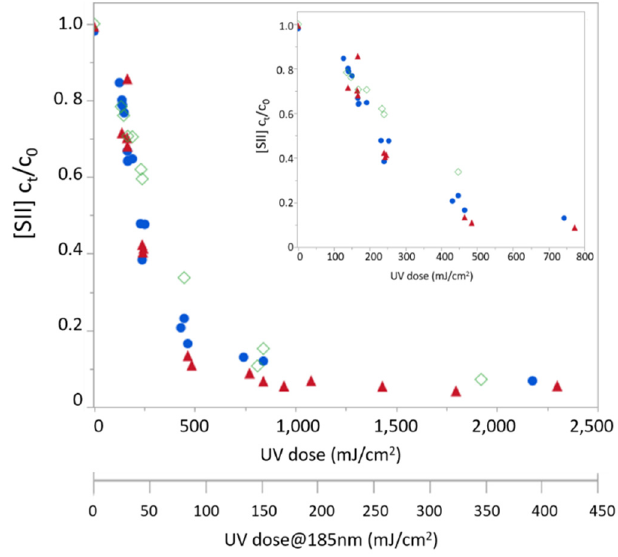
Figure 3. Sulfide removal [SII] under combined radiation (254/185 nm) as a function of radiation dose in distilled water solutions containing different carbonate concentrations. Insert figure zooms on UV does of range 0–800 mJ/cm 2 . Blue circles, red triangles, and green diamonds represent total carbonate concentrations of 0, 1.5, and 3 mM as CaCO 3 , respectively.